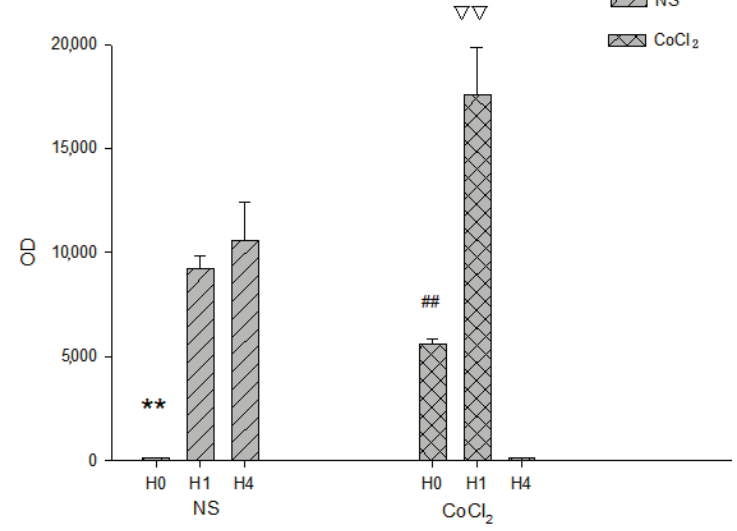
Figure 4. The HIF-1 DNA binding activity in hippocampus of hypoxia-preconditioned mouse treated with CoCl and NS, respectively. ( n = 3; ** p < 0.01 vs. H1 and H4 in NS group; 2 ## p < 0.01 vs. H1 and H4 in CoCl group; ▽▽ p < 0.01 vs. H0 and H4 in CoCl 2